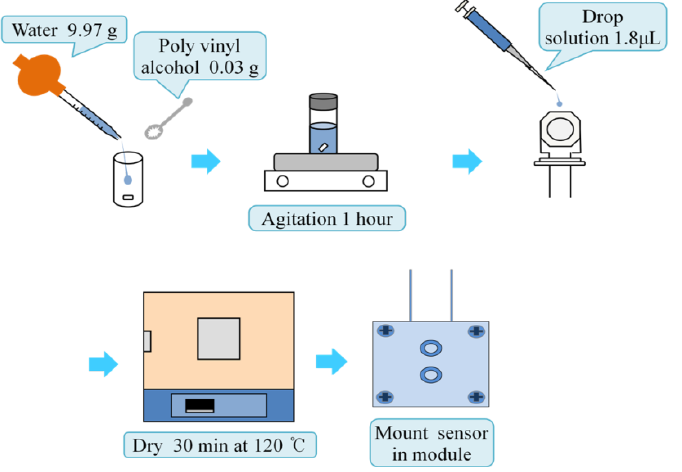
Figure 1. Flowchart of the preparation procedure of PVA coated quartz crystal microbalance.